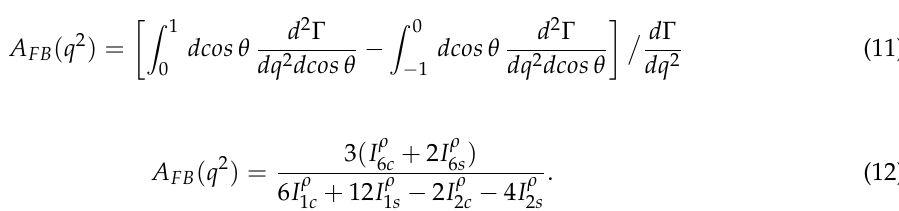
Figure 10. ¯ B → ρ ( ππ ) µ − ¯ ν µ mode: I ρ (cid:101) T = 0 ( middle panel ) and Re ( (cid:101) T ) with (cid:101) P = 0 ( right